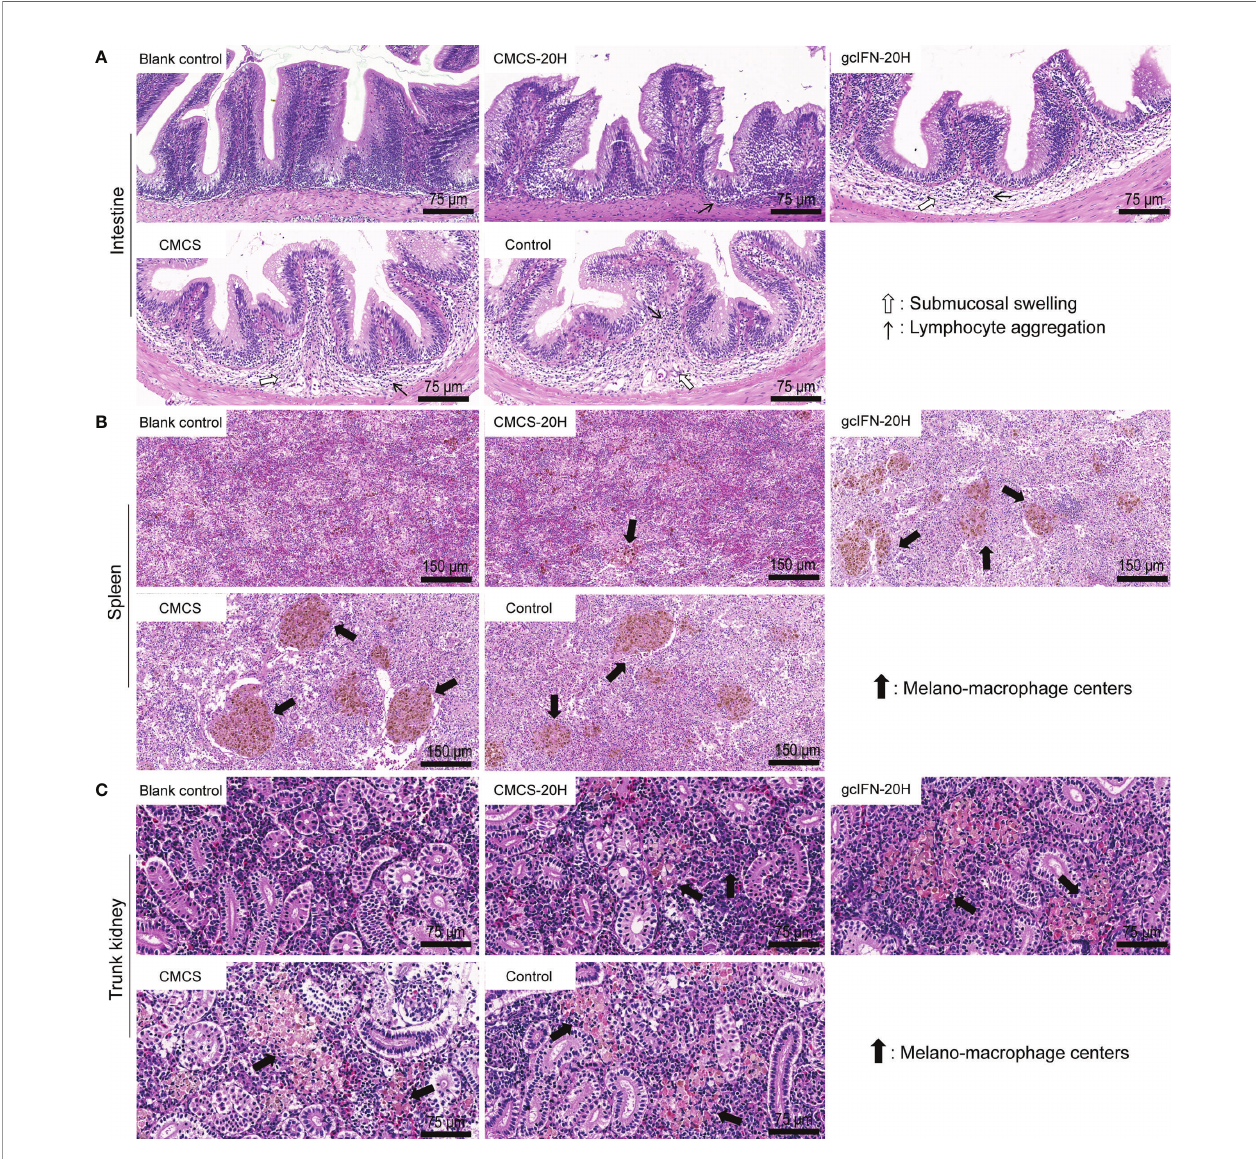
FIGURE 7 | Tissue lesion assays of intestine, spleen, and trunk kidney postoral administration and challenge. On D46, the intestine, spleen and trunk kidney in grass carp were removed to make sections and stained by HE. Healthy grass carp tissues were used as blank control. (A) Histopathologic photographs of intestine. Submucosal swelling and lymphocyte aggregation were two main lesion signs in intestine. (B) Histopathologic photographs of spleen. Melano-macrophage centers were main lesion sign in spleen. (C) Histopathologic photographs of trunk kidney. Melano-macrophage centers were main lesion sign in trunk